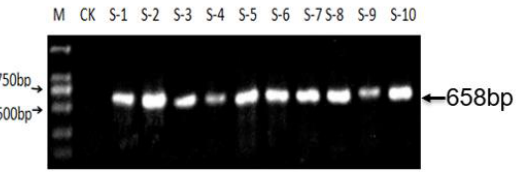
Figure 3. Amplification results of partial T 0 generation transformed plants of Y58S material. M: marker; CK: negative control; S1–S10: part of T 0 transformation plants; 750 bp, 500 bp, 658 bp: fragment size.